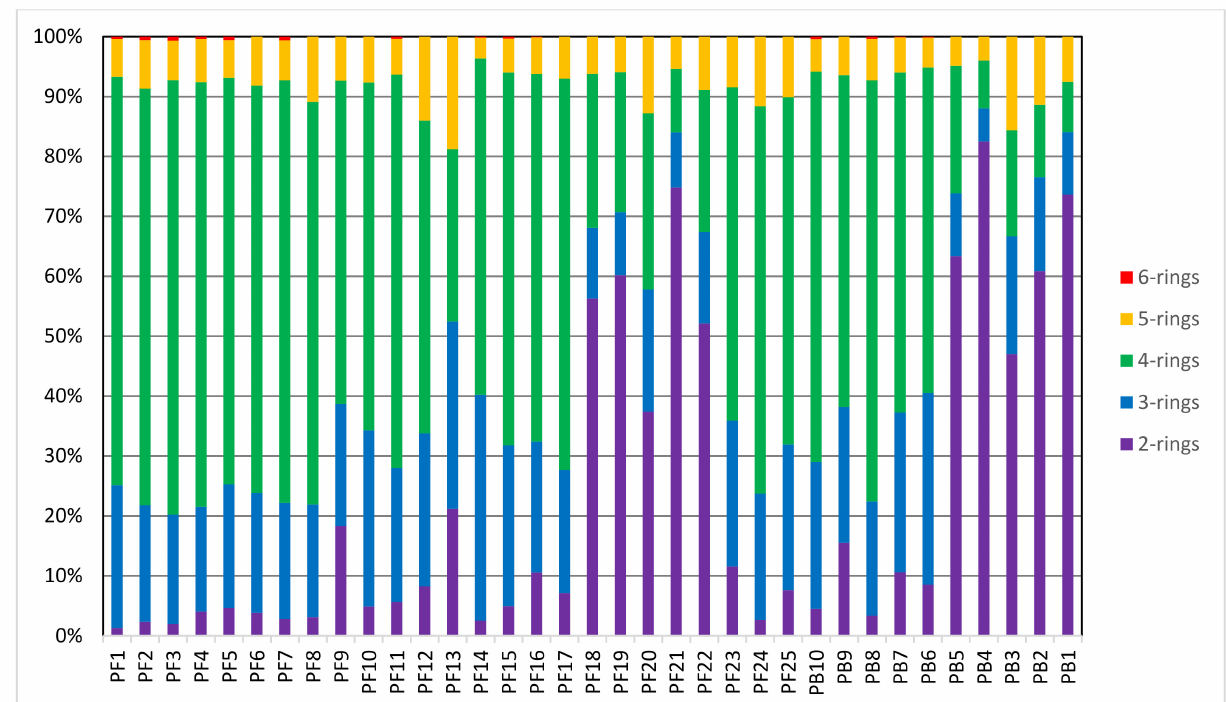
Figure 3. Relative concentrations (%) of PAHs by aromatic